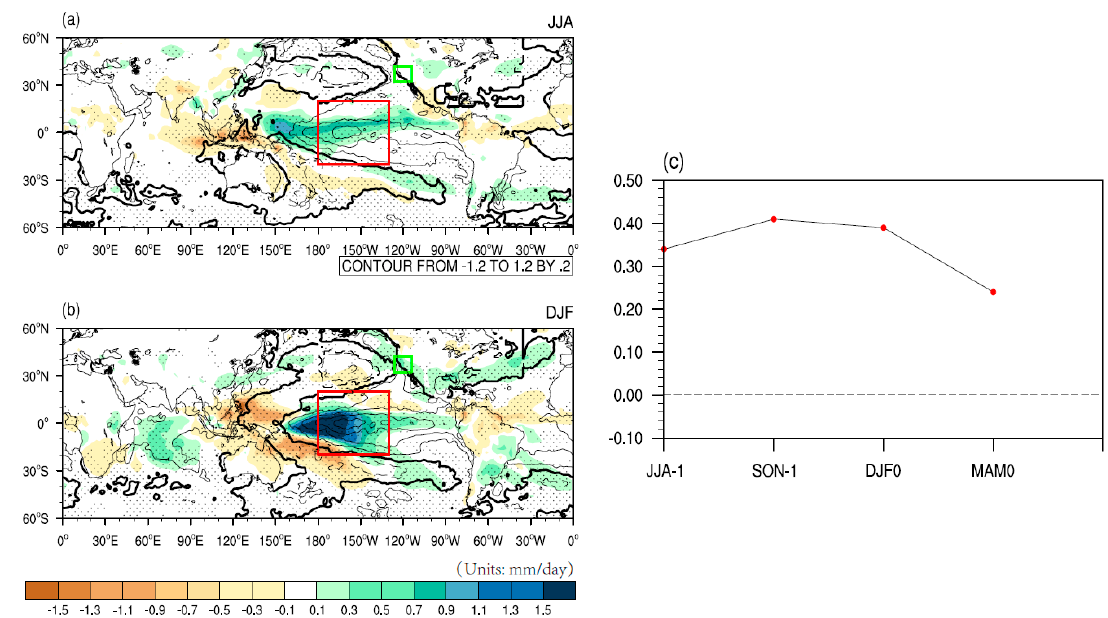
Figure 5. Precipitation (shading; mm/day) and SST (contour; °C) in the preceding summer ( a ) and subsequent winter ( b ) regressed to the box-averaged SST (red box). The green box represents the selected California area. ( c ) Time evolution of box-averaged SST (°C) from the preceding summer to subsequent spring. Areas with dots exceed the 90% confidence level.